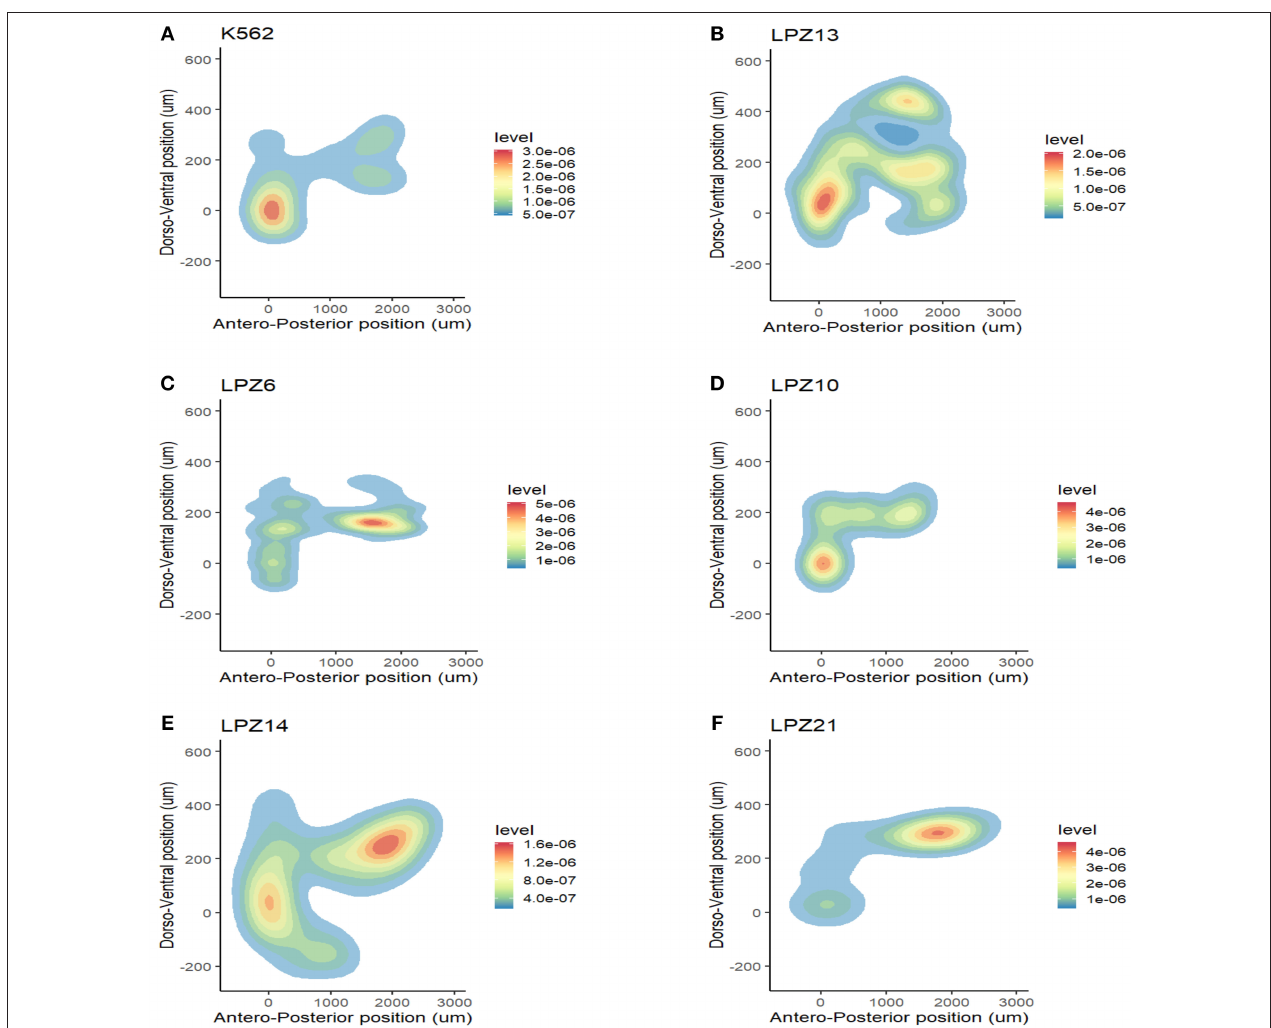
FIGURE 4 | Inter-tumor heterogeneity in migration patterns. Spatial dispersion pattern of cell line xenografts did not resemble the distribution of primary leukemic cells in a complex microenvironment. (A) K562 cell line. K562 is a chronic myelogenous cell line in a blastic crisis. This cell line can be compared to the less differentiated myeloid leukemia subtypes (M0 and M1). (B) M1 sample. Cell line behavior does not resembles PDX behavior. (C–F) Spatial dispersion patterns between primary samples of the same leukemia subtype presented significant differences in their migratory potential. (C,D) Evidence of inter-tumor heterogeneity between AML-M4 samples. (C) LPZ6 (D) LPZ4. (E,F) Evidence of inter-tumor heterogeneity between B-ALL samples. (E) LPZ14 (F)